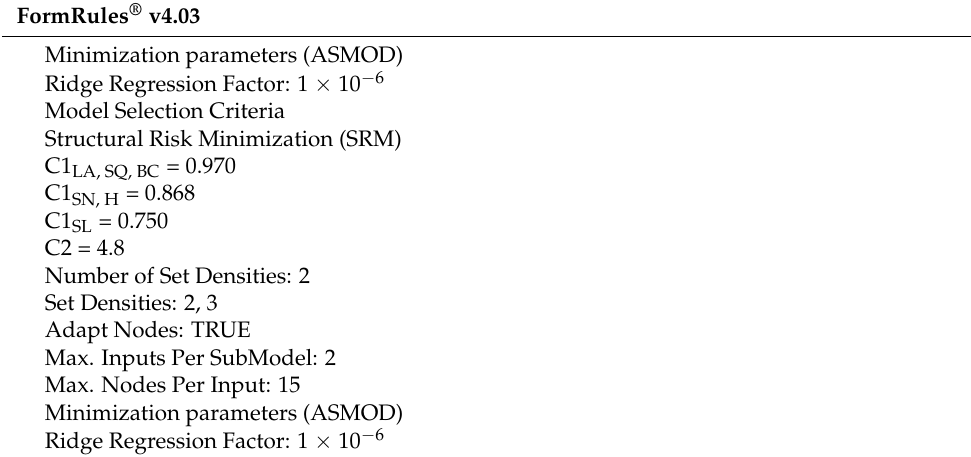
Table 6. Train parameters setting for neurofuzzy logic (FormRules ® v4.03) software. FormRules ®